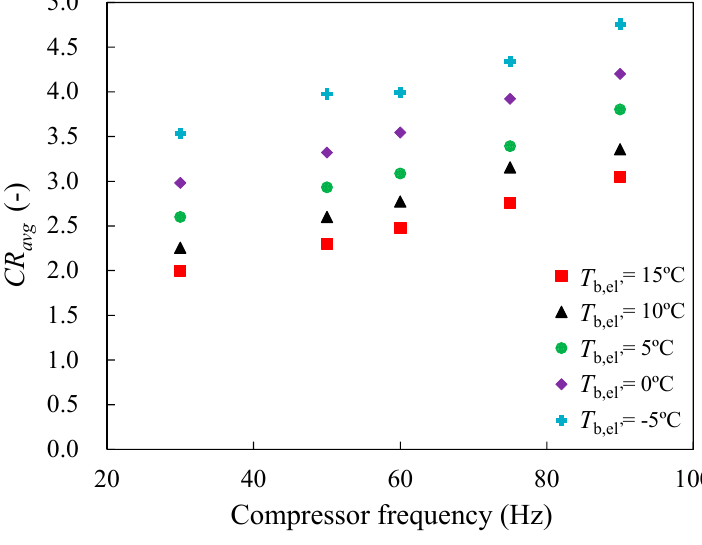
Figure 11. The compression ratio C R avg as a function of compressor frequency.